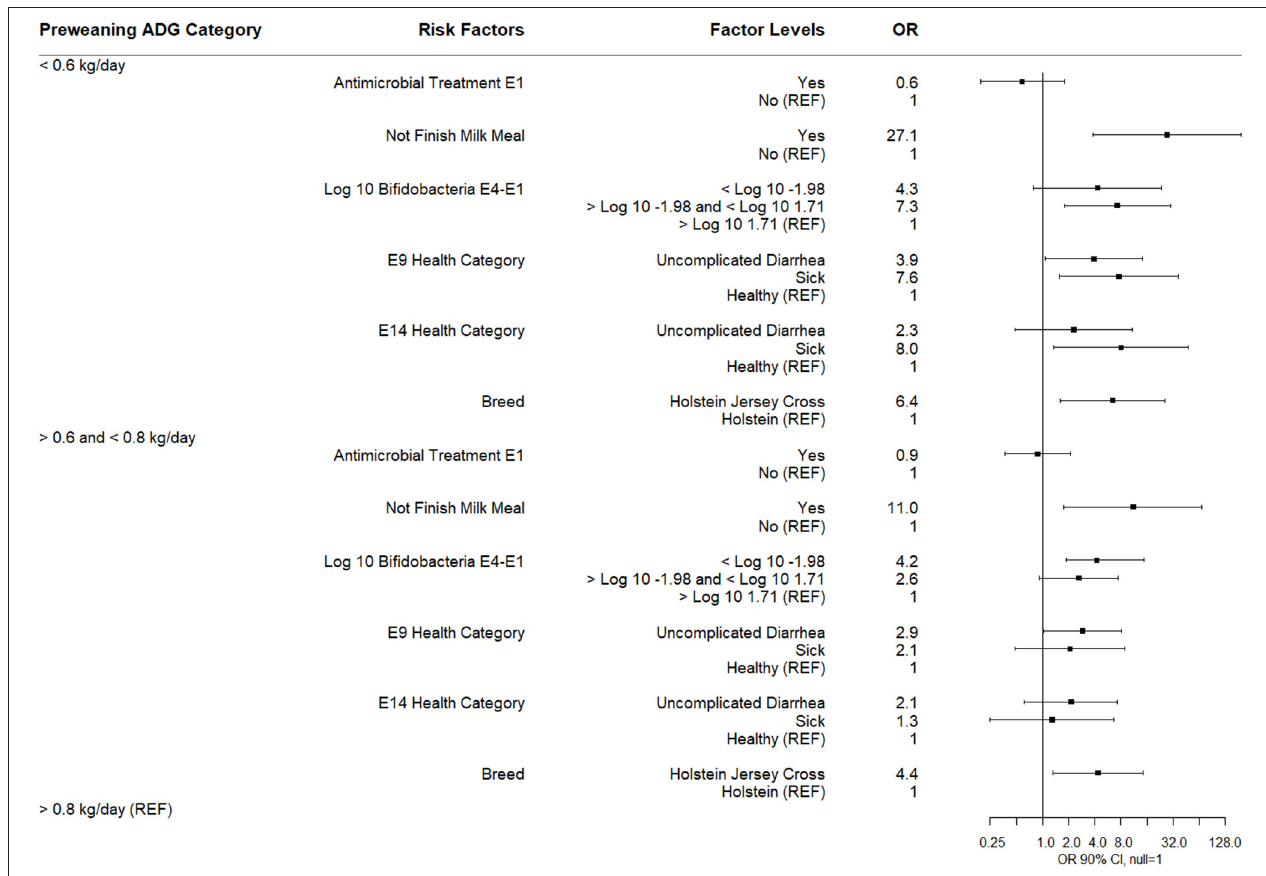
FIGURE 10 | Results of multinomial logistic regression modeling pre-weaning average daily gain. Odds ratios and 90% confidence intervals are shown. Not finish milk meal was defined as: yes (finished milk meals between E1 and E9) and no (did not finish 2 or more milk meals between E1 and E9).